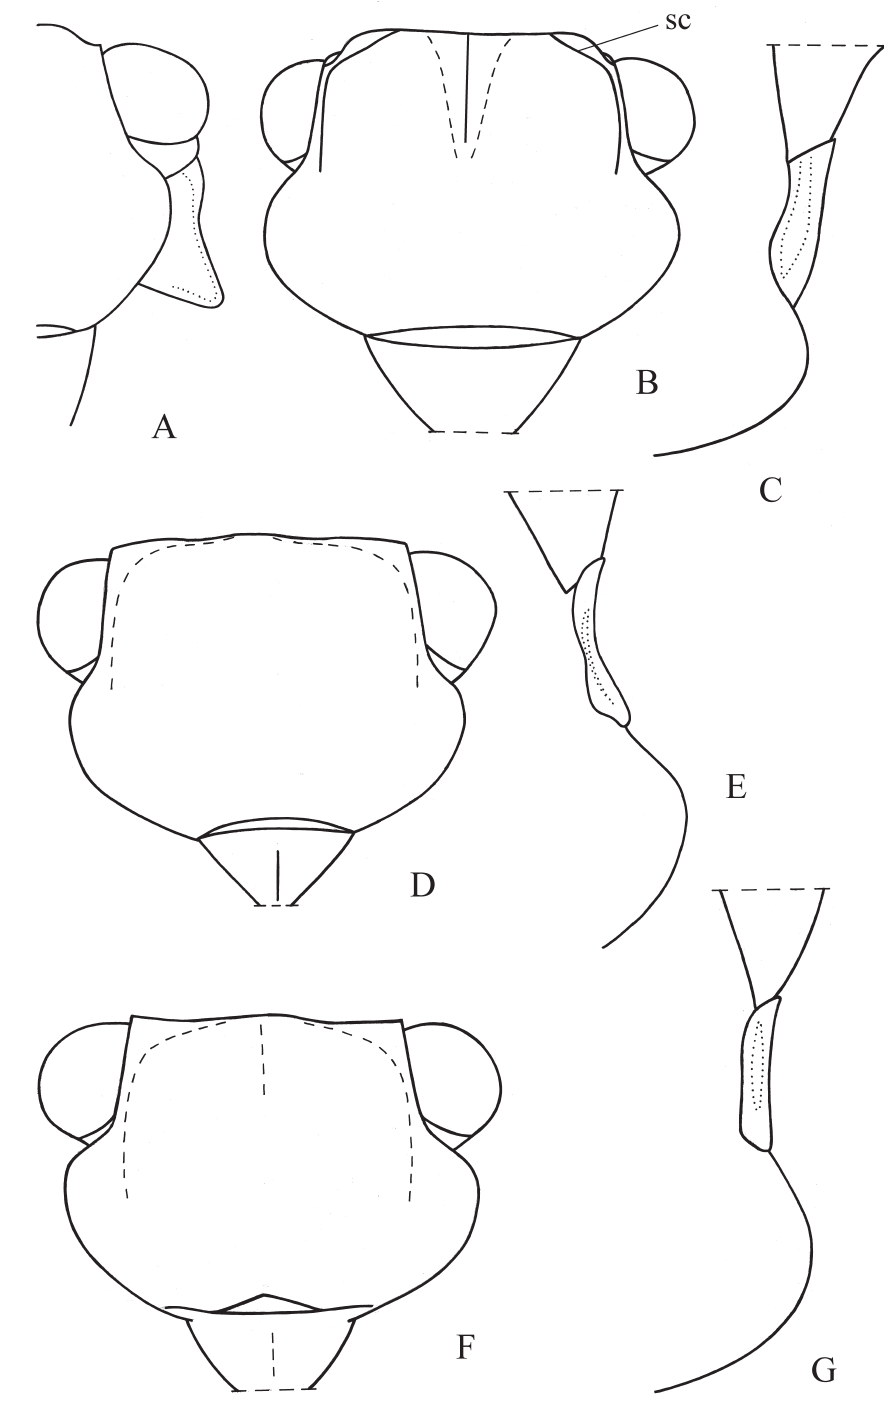
Fig. 4. Superciliaris spp., external view (weak carinae and margins are indicated by dotted lines). A–C . S. anichkini sp. nov., ♂, holotype (ZIN). A . Half of face and left paranotal lobe, frontal view. B . Face, frontal view. C . Tegula and basal part of forewing, lateral view. D–E . S. celebensis sp. nov., ♂, holotype (BMNH). D . Face, frontal view. E . Tegula and basal part of forewing, lateral view. F–G . S. tawaiensis sp. nov., ♂, holotype (BMNH). F . Face, frontal view. G . Tegula and basal part of forewing, lateral view. Abbreviation: sc = sublateral carinae of metope. No to